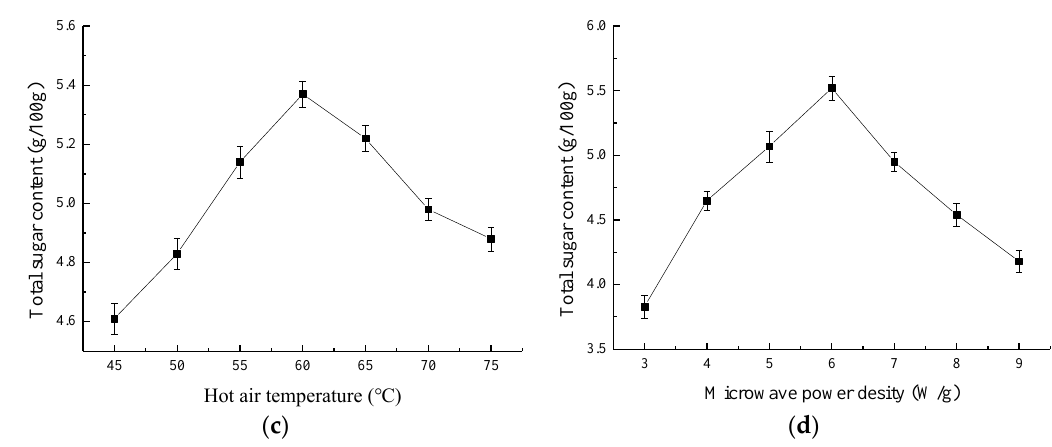
Figure 3. The effects of independent variables on total sugar content (TSC). ( a ) Effect of slice thickness Figure 3. The e ff ects of independent variables on total sugar content (TSC). ( a ) E ff ect of slice thickness of yam slices on TSC; ( b ) Effect of hot-air velocity on TSC; ( c ) Effect of hot-air temperature on TSC; of yam slices on TSC; ( b ) E ff ect of hot-air velocity on TSC; ( c ) E ff ect of hot-air temperature on TSC; ( d ) Effect of microwave power density on TSC. ( d ) E ff ect of microwave power density on TSC.